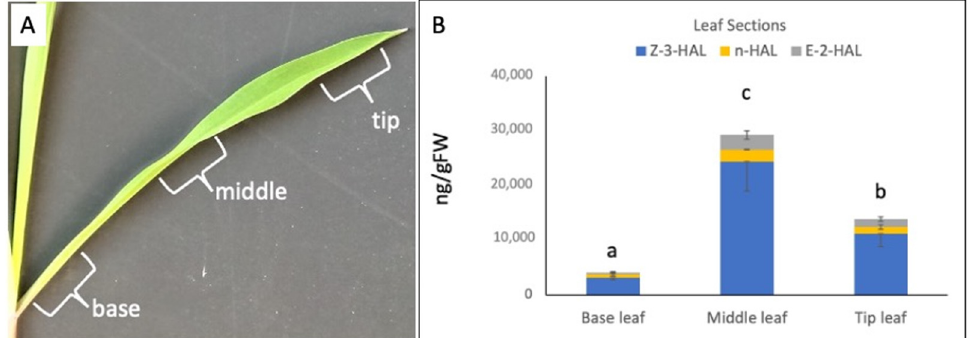
Figure 1. Distribution of the capacity to produce aldehyde GLV in a fully developed maize leaf at the V2 stage. ( A ) A fully developed maize leaf blade from the second leaf is shown with the segments used for this analysis. ( B ) Results for Z-3-hexenal (Z3al), n-hexanal (nHal), and E-2-hexenal (E2al) in base, middle, and tip leaf segments. The values are means ± standard deviation (SD), and the different letters indicate significant differences (ANOVA, p ≤ 0.05, calculated only for the total amount of aldehyde GLV).